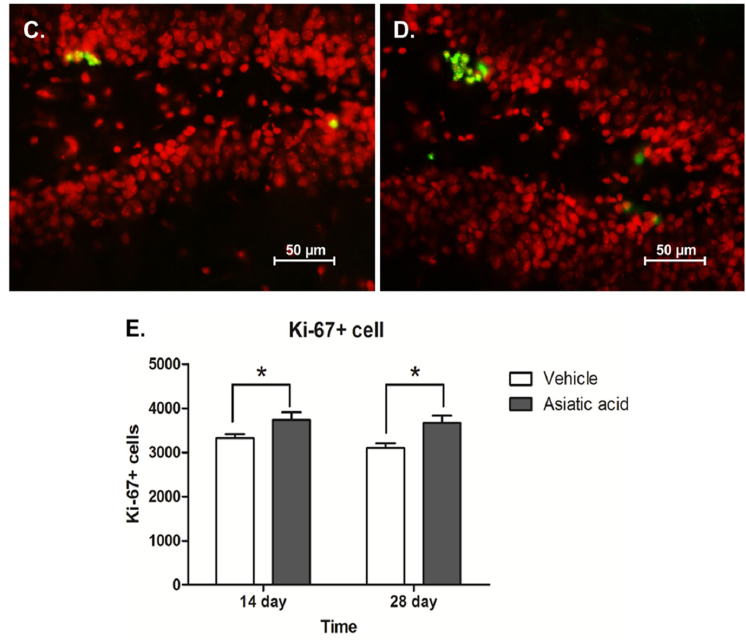
Figure 3. The number of Ki ‐ 67 positive cells in the SGZ (subgranular zone) of the hippocampal dentate gyrus. Ki ‐ 67 positive cells are stained green in the SGZ of the dentate gyrus (section counterstained with red nuclear dye, PI; ( A ) = control 14 day; ( B ) = asiatic acid 14 day; ( C ) = control 28 day and ( D ) = asiatic acid 28 day). The level of proliferating cells in animals receiving asiatic acid for both 14 and 28 days were significantly higher than controls (* p < 0.05) ( E ). A two ‐ way Analysis of variance with Fisher ʹ s Least Significant Difference post hoc test was used to compare between all groups.